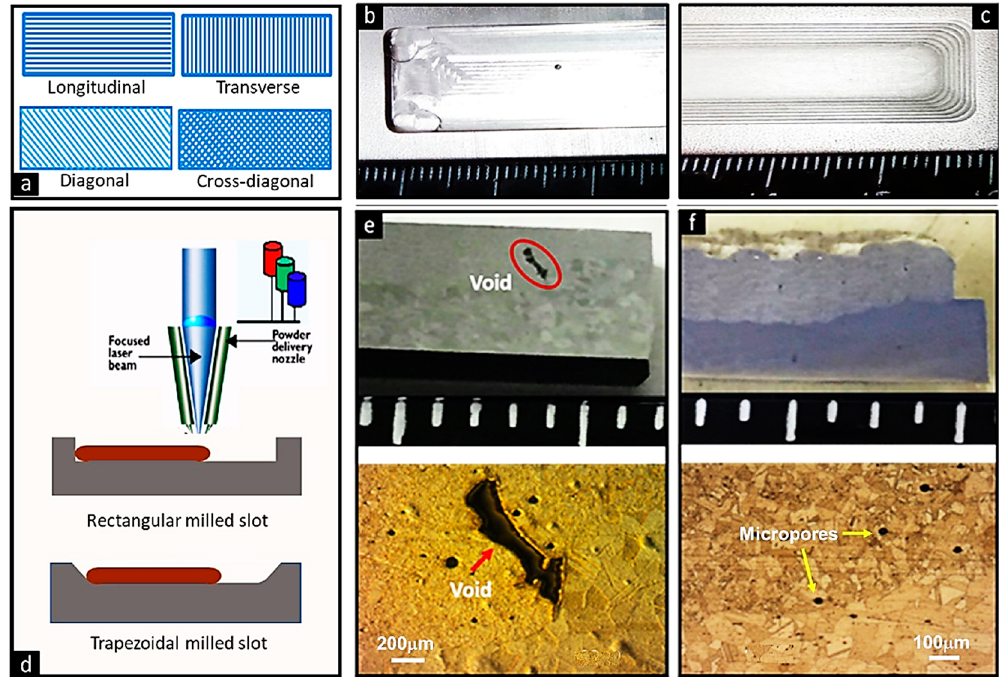
Figure 6. Processing strategies and sample cross-section. ( a ) Different build directions. ( b ) rectangular, ( c ) trapezoidal, milled slots. ( d ) LENS™ deposition schematic. ( e ) Void inclusion on rectangular and ( f ) Smooth transition on trapezoidal, milled slots [80].